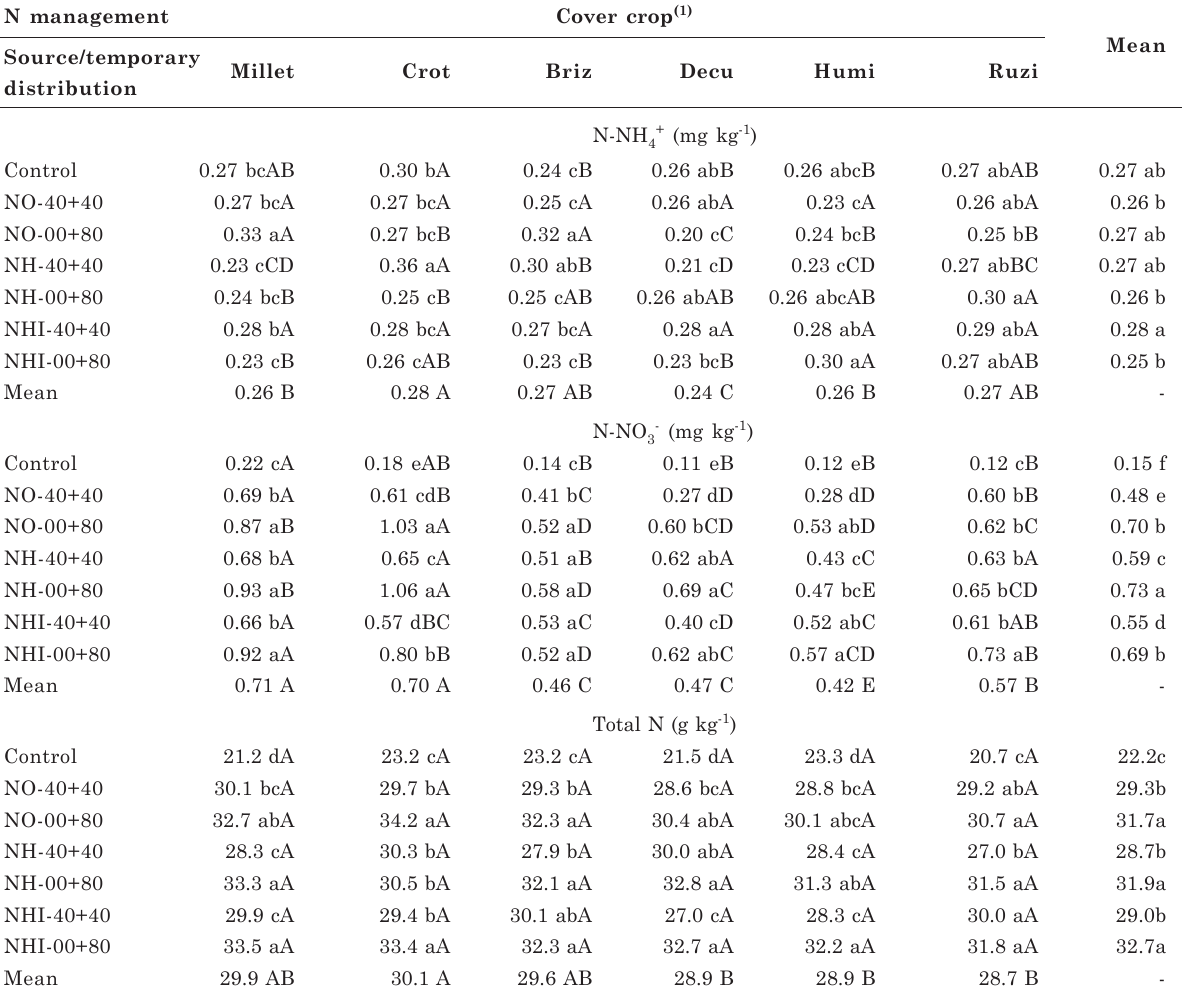
Table 3. Ammonium, nitrate, and total nitrogen concentration in upland rice shoots, 42 days after emergence, as affected by cover crops and nitrogen sources under